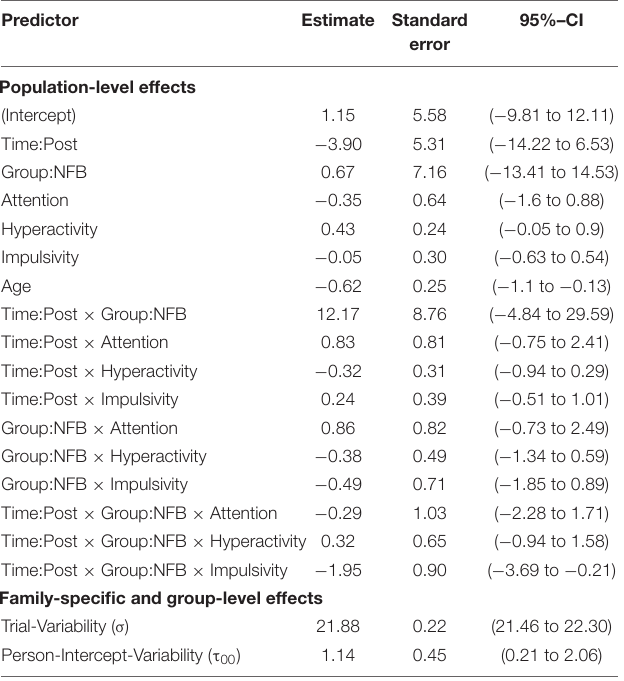
TABLE 3 | Summary of the results obtained by the fine-grained moderator model of CNV amplitude at channel FCz. Predictor Estimate Standard